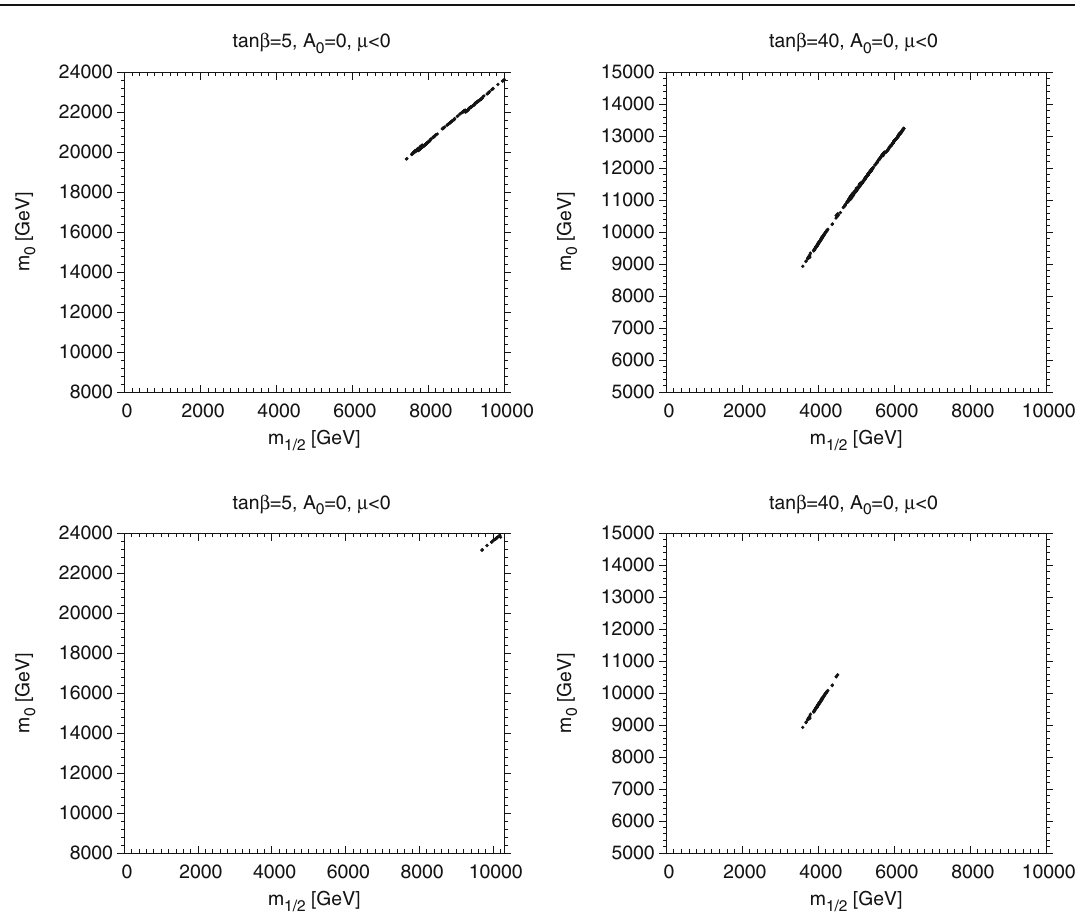
Fig. 20 The portions of the dark matter strips for tan β = 5 and 40, calculated assuming A 0 = 0 and μ < 0, that are allowed by all the constraints, assuming an uncertainty of 1 . 5 ( 0 . 5 ) GeV in the calculation of m h in the upper (lower) pair of